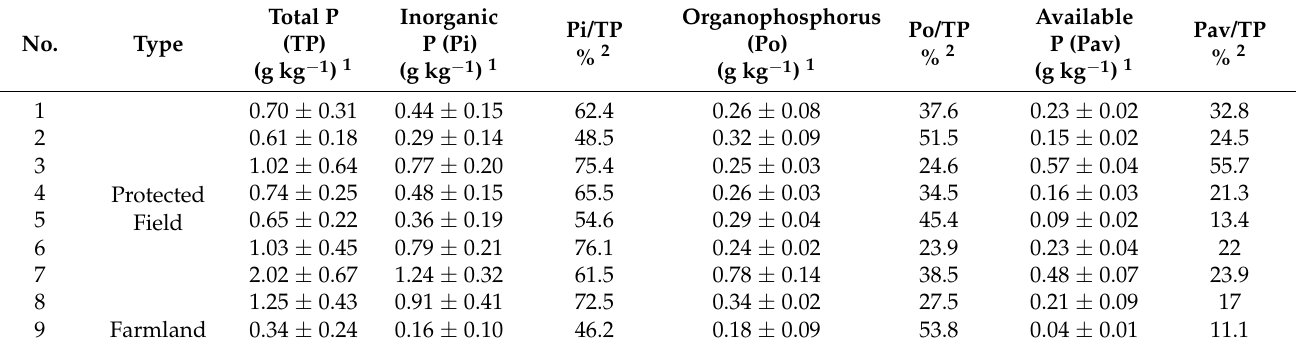
Table 3. Phosphorus composition of the 20–40 cm layer of soils collected from protected